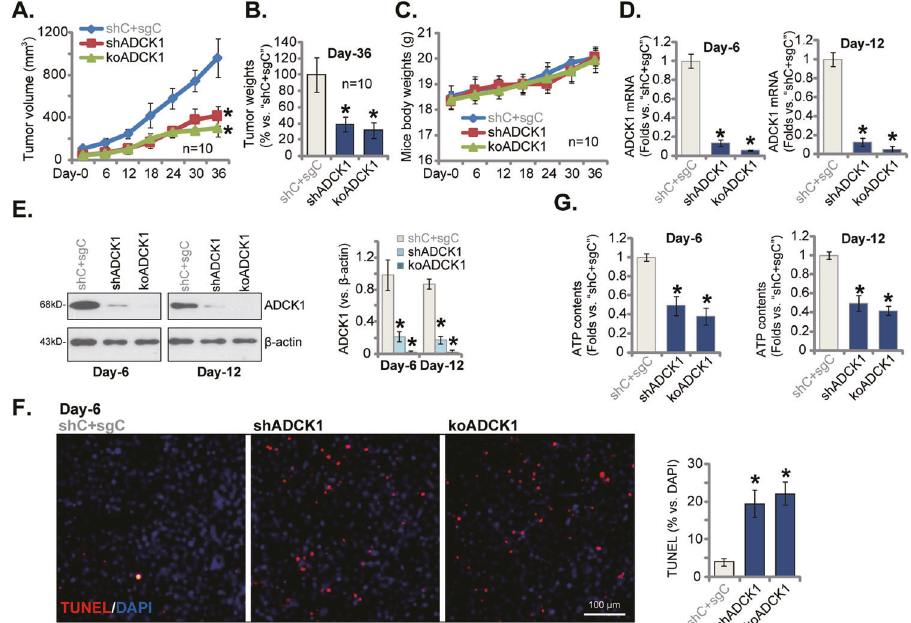
Fig. 8 ADCK1 depletion inhibits OS xenograft growth in vivo. The primary pOS-1 cells bearing the ADCK1 shRNA ( “ shADCK1 ” ), the lentiviral CRISPR/Cas9 construct with sgRNA ( “ sg-1 ” ) targeting ADCK1 ( “ koADCK1 ” ) or the lentiviral scramble control shRNA plus the CRISPR/Cas9 empty vector ( “ shC + sgC ” ) were s.c . injected to the fl anks of nude mice, and xenograft tumors established within two weeks ( “ Day-0 ” ). Estimated tumor volumes ( A ) and mice body weights ( C ) were recorded every six days for 36 days in total; At “ Day-36 ” , tumors of the three groups were isolated and weighted ( B ). At experimental “ Day-6 ” and “ Day-12 ” , one pOS-1 xenograft per group was isolated, and expression of listed genes and proteins in tumor lysates was shown ( D , E ), with ATP contents examined as well ( G ). The representative TUNEL-DAPI immuno- fl uorescence xenograft slide images were presented as well ( F ), with TUNEL-positive nuclei ratio quanti fi ed ( F ). Data were presented as mean ± standard deviation (SD). * P < 0.05 vs. “ shC + sgC ” group. Scale bar = 100 μ m ( F